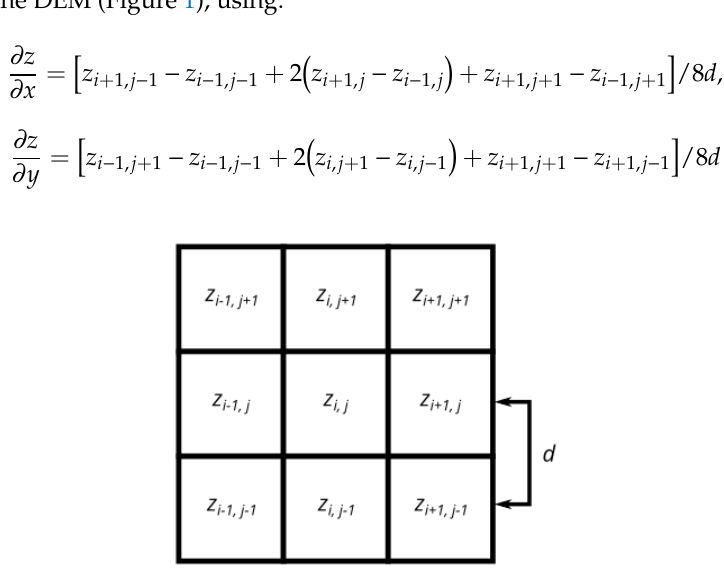
Figure 1. Scheme used to denote the address of the eight elevation values surrounding grid cell, z i,j , in a raster digital elevation model (DEM). The DEM grid resolution, d , is the spacing between neighboring cells.